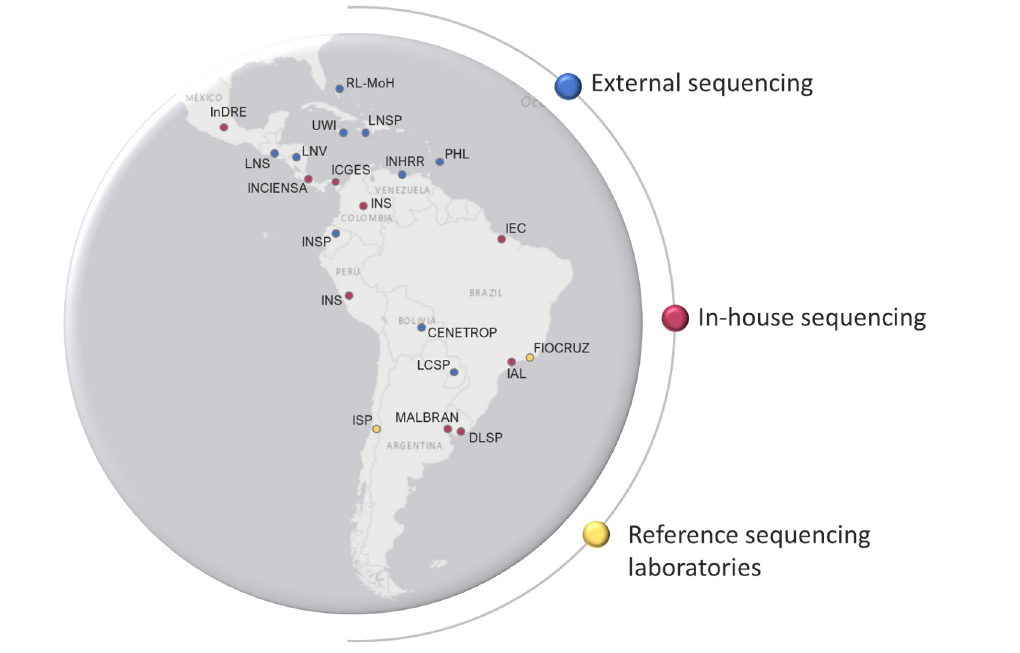
Fig 1. Locations of current laboratories part of the COVID-19 Genomic Surveillance Regional Network in the Americas region. CENETROP—Centro Nacional de Enfermedades Tropicales (Bolivia); DLSP–Departamento Laboratorio de Salud Pu´blica (Uruguay); FIOCRUZ–Fundac¸ ã o Oswaldo Cruz (Brazil); IAL–Instituto Adolfo Lutz (Brazil); ICGES -Instituto Conmemorativo Gorgas de Estudios de la Salud (Panama); IEC–Instituto Evandro Chagas (Brazil); INCIENSA—Instituto Costarricense de Investigacio´n y Ense ñ anza en Nutricio´n y Salud (Costa Rica); InDRE—Instituto de Diagno´stico y Referencia Epidemiolo´gicos (Mexico); INHRR—Instituto Nacional de Higiene Rafael Rangel (Venezuela); INS–Instituto Nacional de Salud (Colombia); INS–Instituto Nacional de Salud (Peru); INSPI–Instituto Nacional de Investigacio´n en Salud Pu´blica (Ecuador); ISPCH–Instituto de Salud Pu´blica (Chile); LCSP–Laboratorio Central de Salud Pu´blica (Paraguay); LNS–